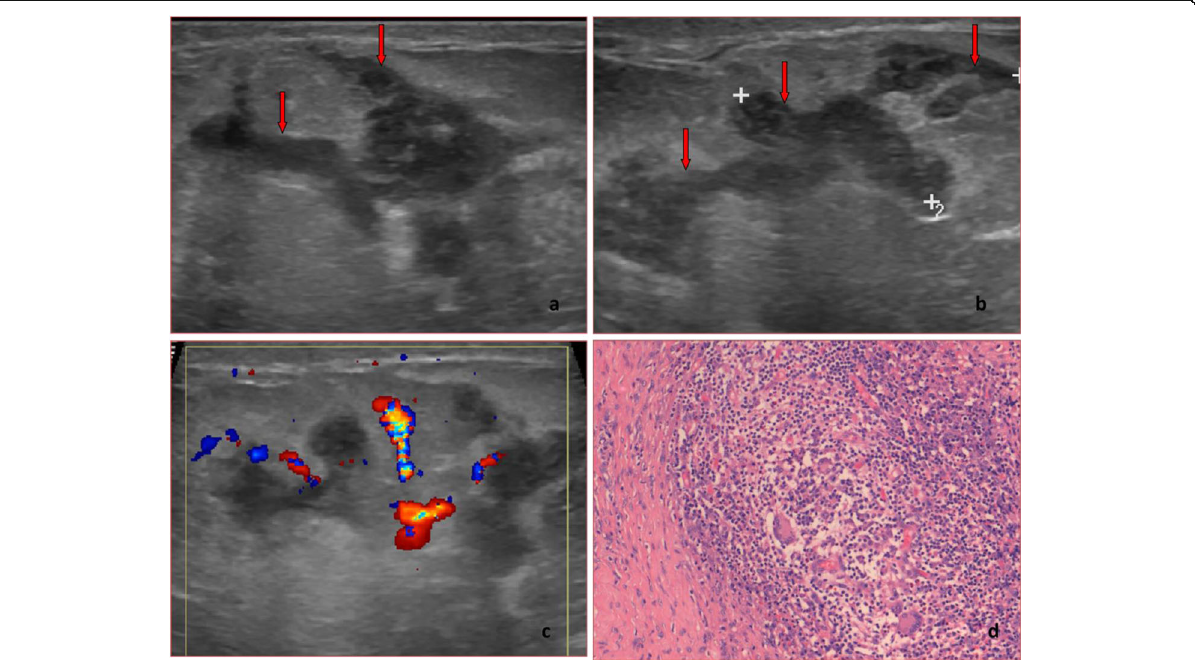
Fig. 1 Ultrasound of a 28-year-old female diagnosed with idiopathic granulomatous mastitis, who presented with pain and swelling in the left breast. a , b Ultrasound showing an ill-defined irregular hypoechoic lesion with tubular tentacle-like extensions (red arrows). c Color flow imaging showing increased internal vascularity. d Histopathology shows Langhans type of giant cells admixed with inflammatory cells, predominantly lymphocytes (H&E × 100)